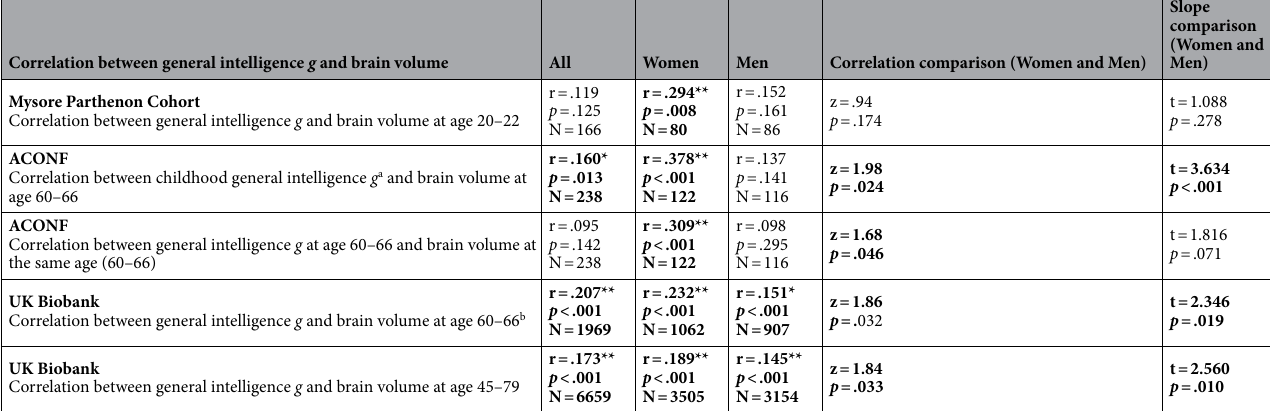
Table 6. Pearson correlations between brain volume and general intelligence g and correlation comparison between sexes; where r is the correlation coefficient; **correlation is significant at the .01 level (2-tailed), *correlation is significant at .05 level (2-tailed), the probability p < .05 is uncorrected; test statistic z for correlation comparison (First transformed the r to Z using the Fisher Z transformations so that they were normally distributed and then applied a Z test where the differences in the Z measured was divided by the standard error. A Z score of greater than ± 1.96 was considered significant), and t statistic for the slope difference. The significant values are shown in bold. a Childhood general intelligence g data are